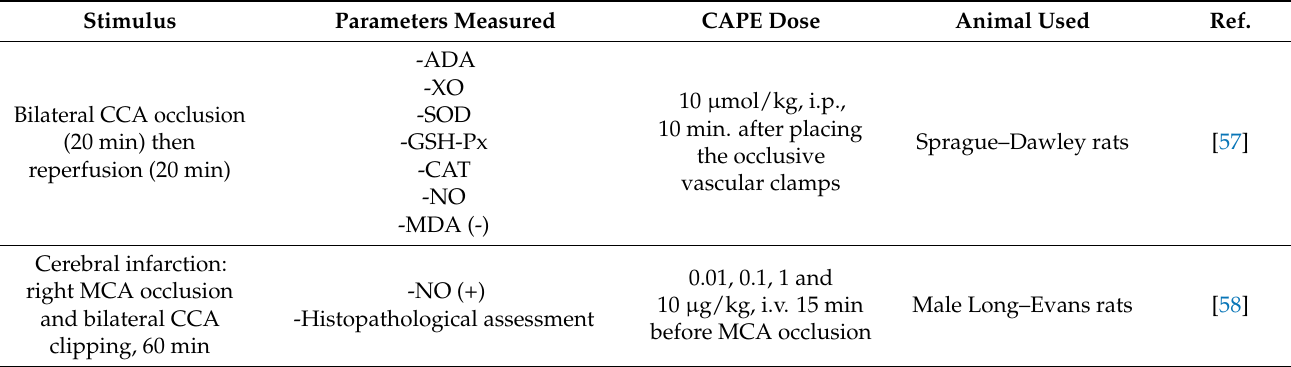
Table 3. CAPE protective effects against ischemia/reperfusion injury. Where applicable, the effect of CAPE on the parameters measured is reported between parentheses (+ or −